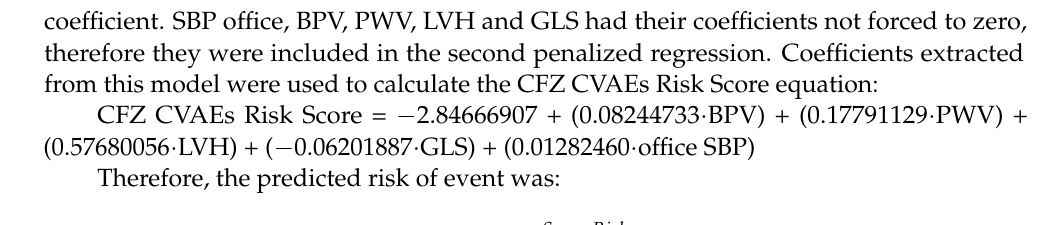
Figure 4 . CFZ CVAEs Risk Score Discrimination plot.